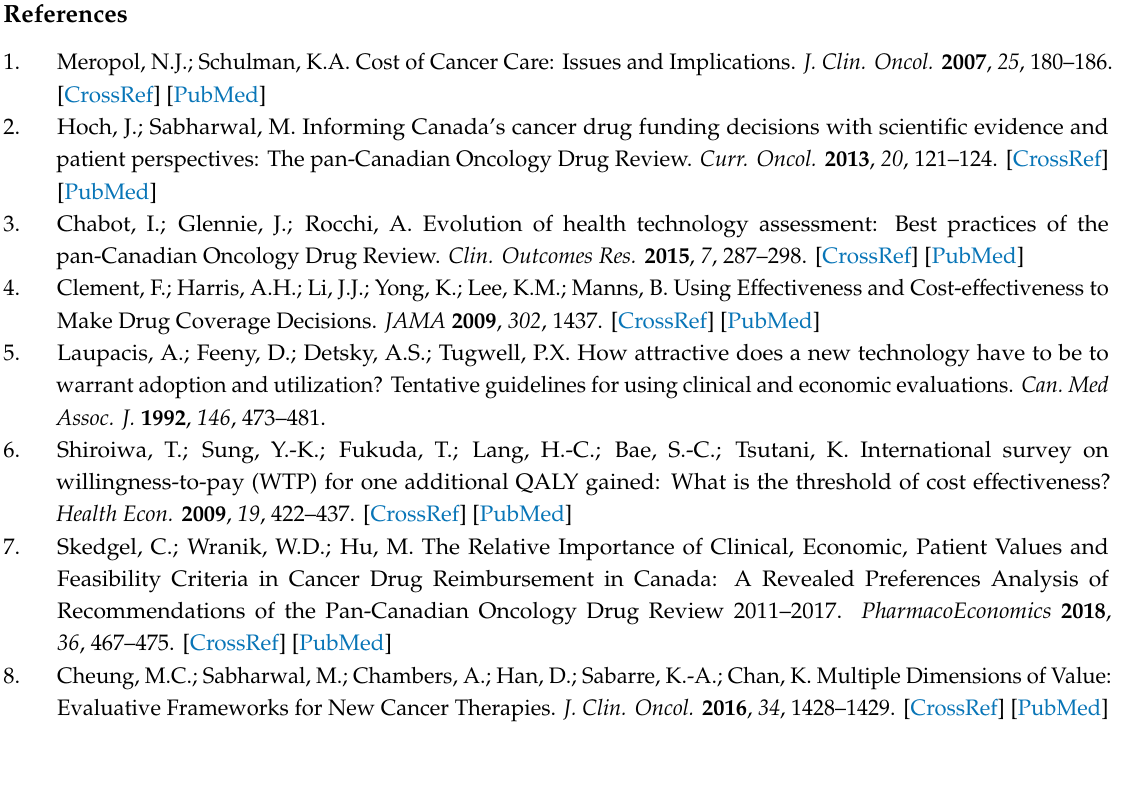
Table S1: Characteristics of the included submission. Table S2: Economic values of the included submissions. Table S3: Summary Statistics for Manufacturer submitted and EGP-reanalyzed ICERs ($ / QALY). Figure S1: Average ICERs generated by the manufacturer-submitted and EGP-re-analyzed economic models. Figure S2: Change in manufacturer-submitted and EGP-reanalysed ICERs over time. Cost is presented in CAD. Author Contributions: K.K.W.C., M.C. and R.S. conceived and designed the analysis. R.S., T.J., and L.K. collected the data. R.S., T.J. and K.K.W.C. performed the analysis. R.S. wrote the manuscript. All authors contributed to the final submission of this manuscript. All authors have read and agreed to the published version of the